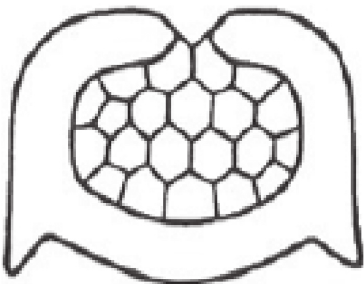
Figure 5: Open wings with core exposed or folded down into core but not touching (i.e., not locked).